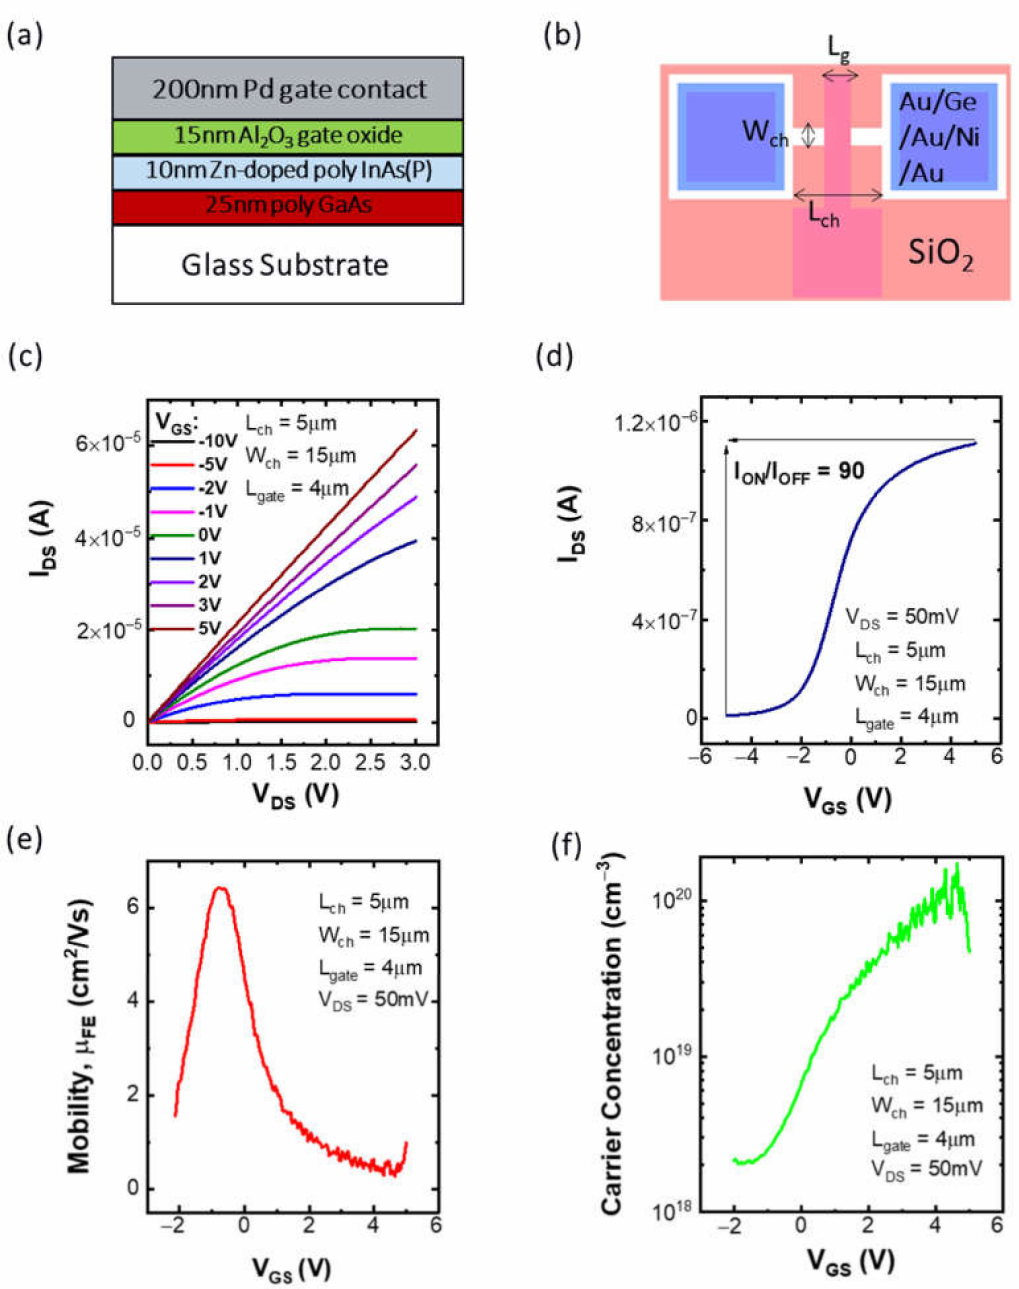
Figure 4. ( a ) Schematic cross-section of film structure in the channel region of the device where gate oxide Al 2 O 3 and gate metal Pd were used. ( b ) Plan-view of device layout. ( c ) Device output and ( d ) transfer characteristics at room temperature. ( e ) Field-effect mobility, and ( f ) carrier concentration extracted from transconductance (method in Supplementary Materials). Hall mobility prior to device fabrication = 18 cm 2 /V ·